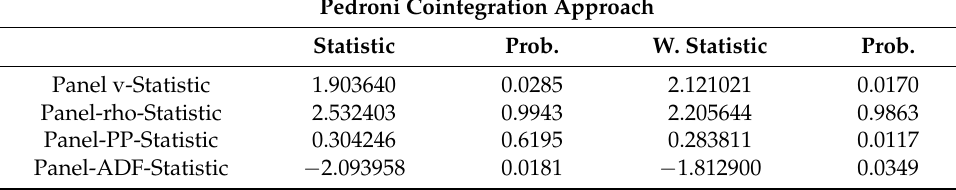
Table 4. Cointegration